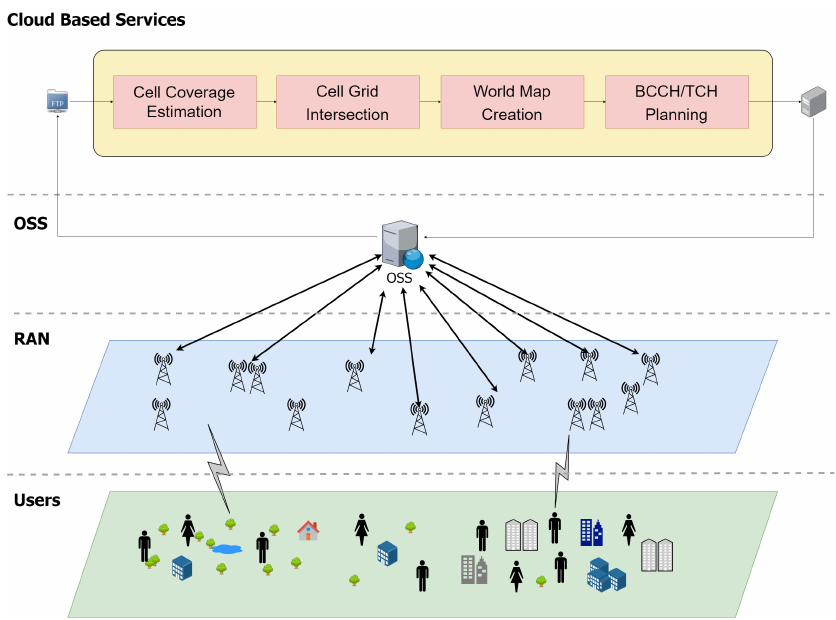
Figure 7. RAN architecture, integrating the proposed cloud-based work pattern for network monitoring and planning.